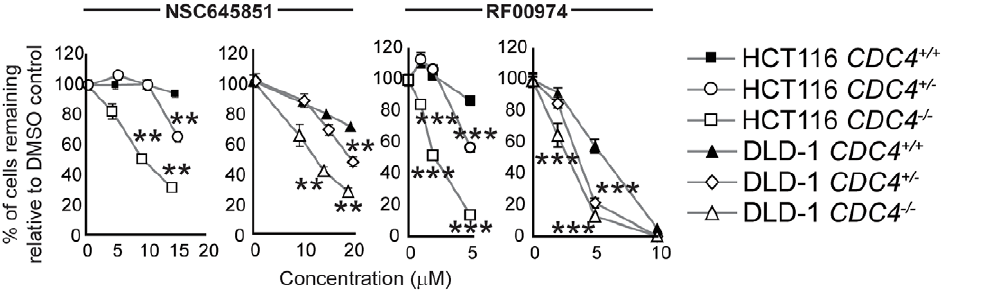
Figure 5. NSC645851 and RF00974 selectively inhibit the proliferation of HCT116 and DLD-1 cells with both homozygous and heterozygous inactivating mutations of CDC4 . Experiments were carried out as described in Figure 4B. Data were analyzed by one-way ANOVA followed by a Tukey test. Shown is mean 6 SEM. * p , 0.05; ** p , 0.01; *** p , 0.001.